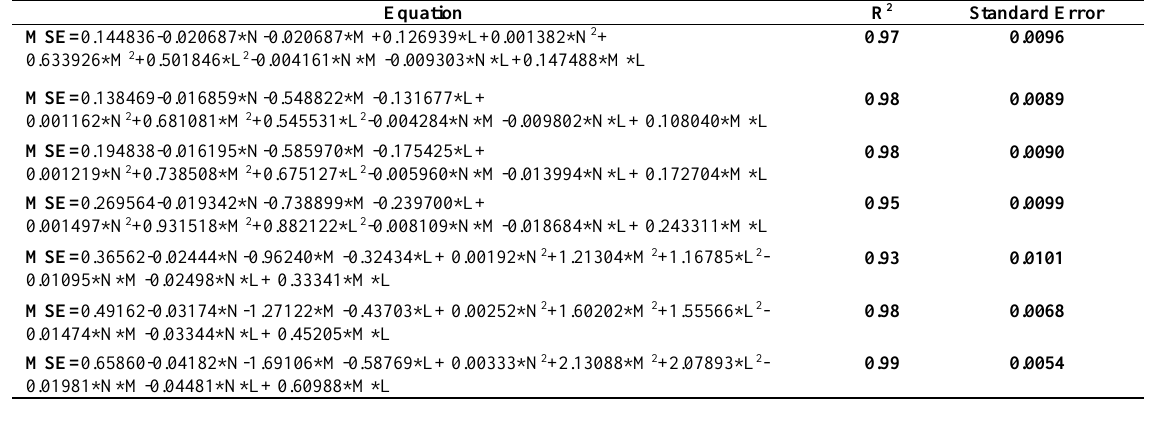
Table 3. The regression equations representing the relation existed between number of neurons (N), coefficient of momentum (M) and learning rate (L) with